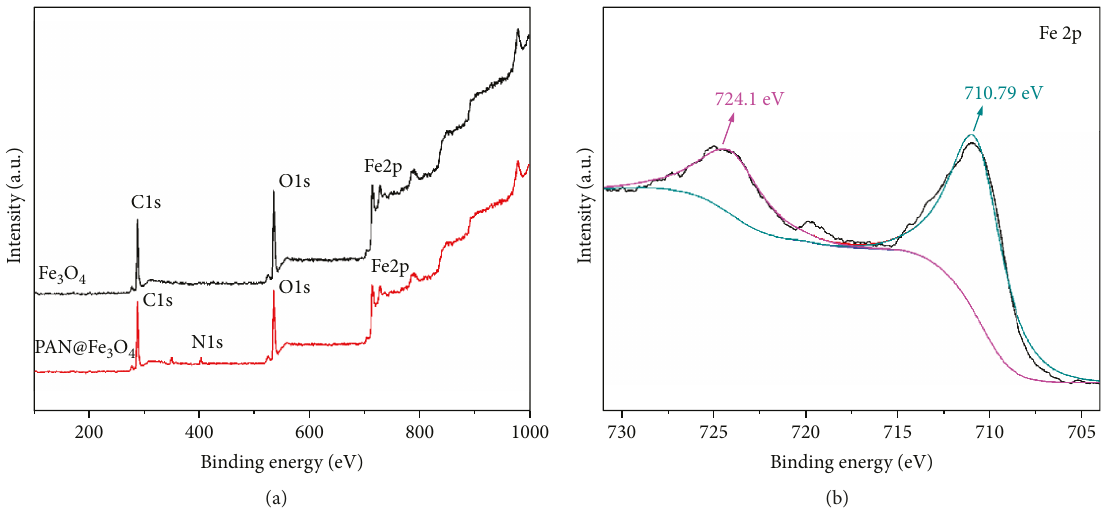
Figure 2: XPS spectra of Fe